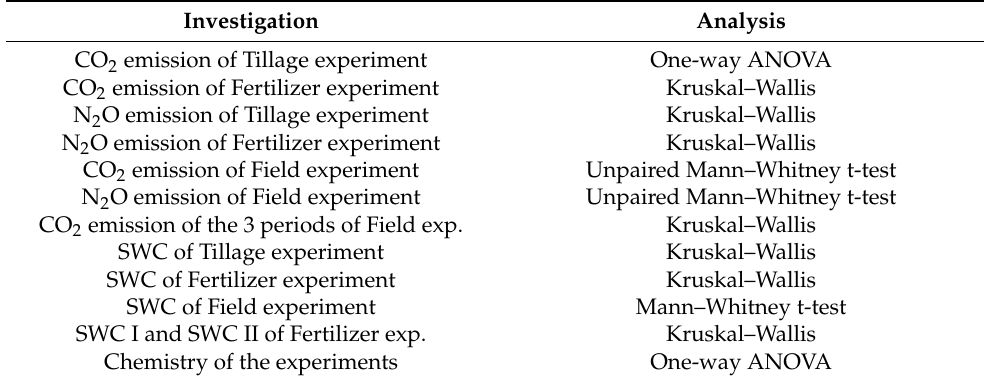
Table 5. Statistical analysis of the different experiments. ANOVA refers to analysis of